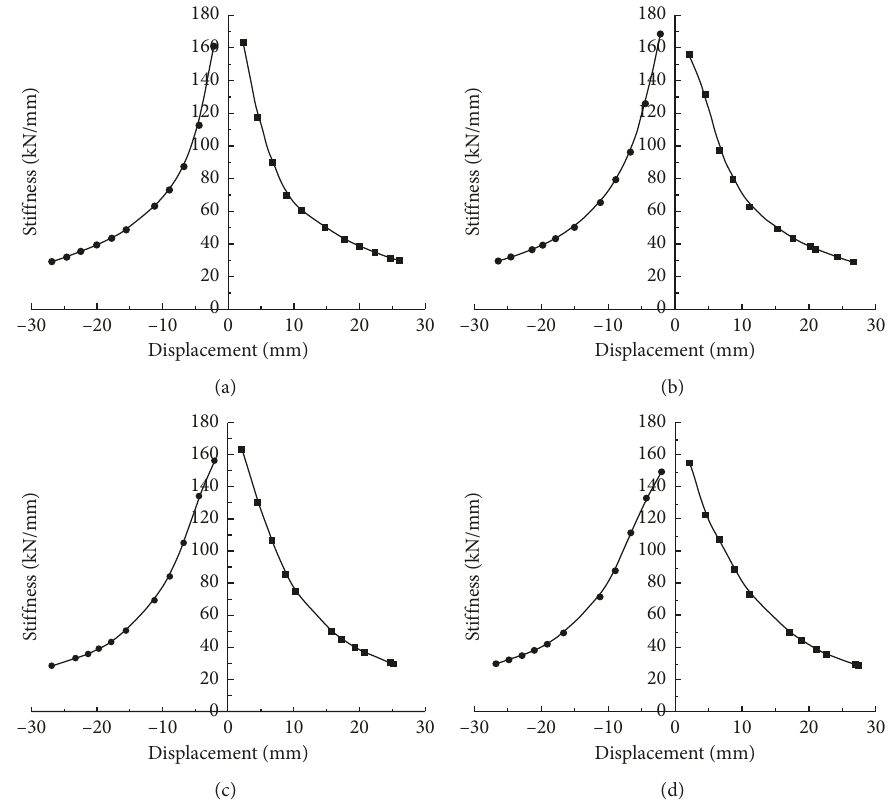
Figure 20: Stiffness degradation curves of frames with various axial compression ratios. (a) K-8. (b) K-1. (c) K-9. (d)